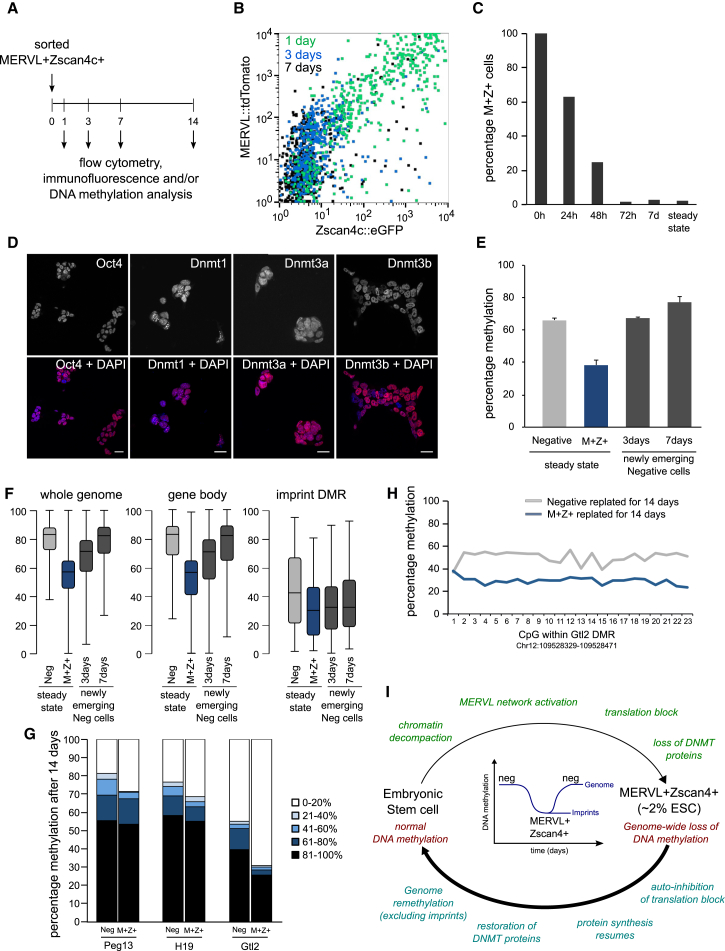
Epigenetic Consequences of Passing through the MERVL+Zscan4+ State(A) Schematic showing release experiment in which MERVL+Zscan4c+ cells were purified from the steady-state population by flow cytometry sorting of the Zscan4c+ MERVL+ gate, followed by re-culturing. At the indicated time points, cells were re-analyzed by flow cytometry and the Zscan4c/MERVL-negative population collected for immunofluorescence and/or methylation analysis.(B) Flow cytometry profiles of sorted MERVL+Zscan4c+ (M+Z+) cells following re-culturing for 24 hr (green), 72 hr (blue), or 7 days (black).(C) Quantification of the proportion of cells remaining in the MERVL+Zscan4+ state (MERVL+ and/or Zscan4c+) at various time points following re-culturing of the sorted cells.(D) Immunofluorescence staining of sorted MERVL+Zscan4c+ cells that were re-cultured for 14 days. Top row shows Oct4 (first column), Dnmt1 (second column), Dnmt3a (third column), and Dnmt3b (last column). Bottom row depicts merge with DAPI in blue. Scale bar represents 25 μm.(E) Genome-wide methylation levels determined by PBAT analysis. Steady-state negative-sorted (light gray) and MERVL+Zscan4c+ sorted (M+Z+, dark blue) cells are shown in the first two columns. The last two columns (dark gray) reflect cells that have exited the MERVL+Zscan4c+ state. To identify these, MERVL+Zscan4c+ cells were isolated by flow cytometry and returned to culture. After 3 or 7 days, cells were sorted again. Those lacking MERVL/Zscan4c reporter expression are defined as newly emerging negative cells. Bars represent the mean ± SD of three biological replicates of 100 cells each.(F) Box plots showing distribution of methylation levels for whole-genome, gene bodies, and imprint DMRs. Steady-state negative-sorted (light gray) and MERVL+Zscan4c+ sorted (M+Z+, dark blue) cells are shown in the first two columns for each feature analyzed. The last two columns (dark gray) reflect cells that have exited the MERVL+Zscan4c+ state identified as in (E) above.(G) Methylation analysis of Peg13, H19, and Gtl2 imprinted DMRs. Cells were sorted from either negative gates (first of bar pairs) or as MERVL+Zscan4c+ positive (second of bar pairs) and returned to culture for 14 days, and analysis was performed on the resulting bulk population. Imprint DMRs were amplified from bisulfite-treated DNA and sequenced giving >1,000-fold coverage. Reads were binned based on their total amount of methylation (0%–20% white, 21%–40% light blue, 41%–60% medium blue, 61%–80% dark blue, and 81%–100% black).(H) Average methylation levels for each CpG within Gtl2 DMR for negative (gray) or MERVL+Zscan4c+ (M+Z+, blue) cells that had been initially sorted and then replated for 14 days.(I) MERVL endogenous retrovirus activation induces genome-wide DNA demethylation. Embryonic stem cells cycle in and out of the MERVL+Zscan4+ state. Entry into the state is initiated by chromatin decompaction, which enables accessibility of transcription factors, resulting in activation of the MERVL-LTR-driven transcriptional network. Subsequently, inhibition of protein synthesis depletes DNMT protein levels in the cell, which results in genome-wide DNA demethylation. Upon exit from the MERVL+Zscan4+ state, the translation block is lifted through auto-inhibition, protein synthesis resumes, and DMNT protein levels return to normal. While genome-wide methylation levels are restored, genomic imprints remain unmethylated, potentially explaining how imprints are lost in long-term ESC cultures.